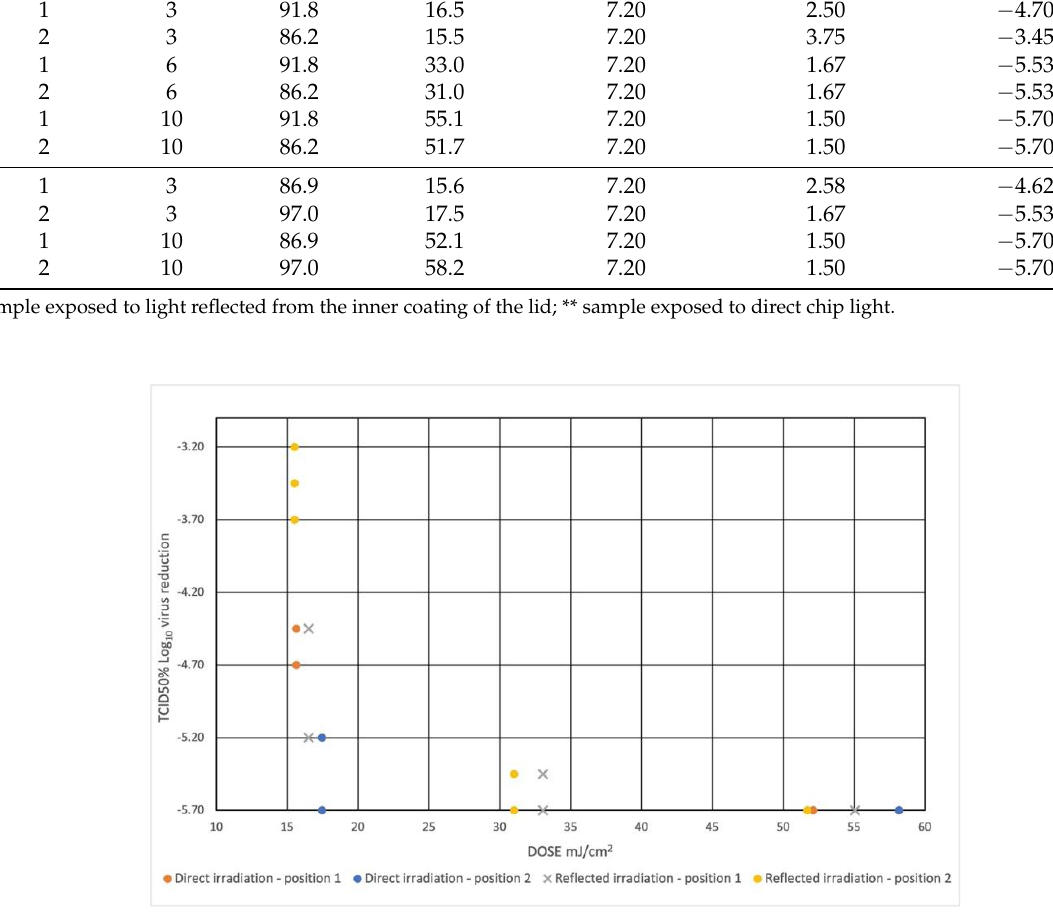
Figure 6. Dispersion plot shows the virus concentration reduction based on the irradiation dose to which it was exposed. The value of Log TCID 50 % = 1.50 means total viral inactivation—limit of detection. The initial concentration of viral suspension of SARS-CoV-2 was 10 7.2 TCID 50 Table 2. Evaluation of the virucide activity on SARS-CoV-2.